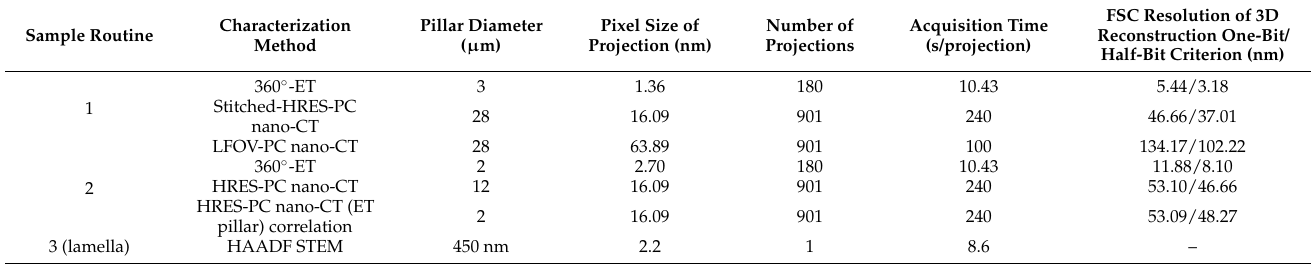
Figure 3. Comparison of the utilized correlative tomography techniques: ( A ) LFOV–PC image of the FIB-prepared SCALMS pillar structure (Figure 2D, sample routine 1) with a diameter of ~28 µ m. The red rectangle indicates the position of the pillar structure prepared for the 360 ◦ -ET experiment. ( B ) Stitched-HRES-PC nano-CT projection image showing the same pillar as in ( A ). The distribution of Ga-Pd droplets (dark spots) is clearly revealed. The position, where the smaller pillar for the 360 ◦ -ET experiment was cut out via FIB milling (red rectangle), is not contained in the FOV. ( C ) HAADF STEM image of the pillar prepared for 360 ◦ -ET experiments. Distinct Ga droplets with Pd (bright areas at the edges of the droplets) are revealed. ( D ) Virtual slice through the reconstructed LFOV-PC nano-CT dataset. The red and blue arrows indicate Ga-Pd droplets in the 3D volume being resolved but with very low detail. Material defects like cracks (yellow arrow) in the glass network are resolved as well. ( E ) Virtual slice through the reconstructed stitched-HRES-PC nano-CT dataset of the same area as in ( D ). Ga-Pd droplets (red and blue arrows) and material defects (yellow arrow) are represented with higher precision. Moreover, the macropores of the glass network are resolved and the Ga-Pd droplets are revealed to be embedded in the porous network in a branch-like manner. ( F ) Virtual slice through the reconstructed 360 ◦ -ET dataset revealing bright contrast in the outer and darker contrast in the central areas of the Ga-Pd droplets indicating Pd-rich and Ga-rich regions, respectively. The droplets are embedded in the porous support network in several interconnected pores. Table 1. Overview of the analyzed SCALMS samples with important parameters of image acquisition and 3D reconstruction. Sample